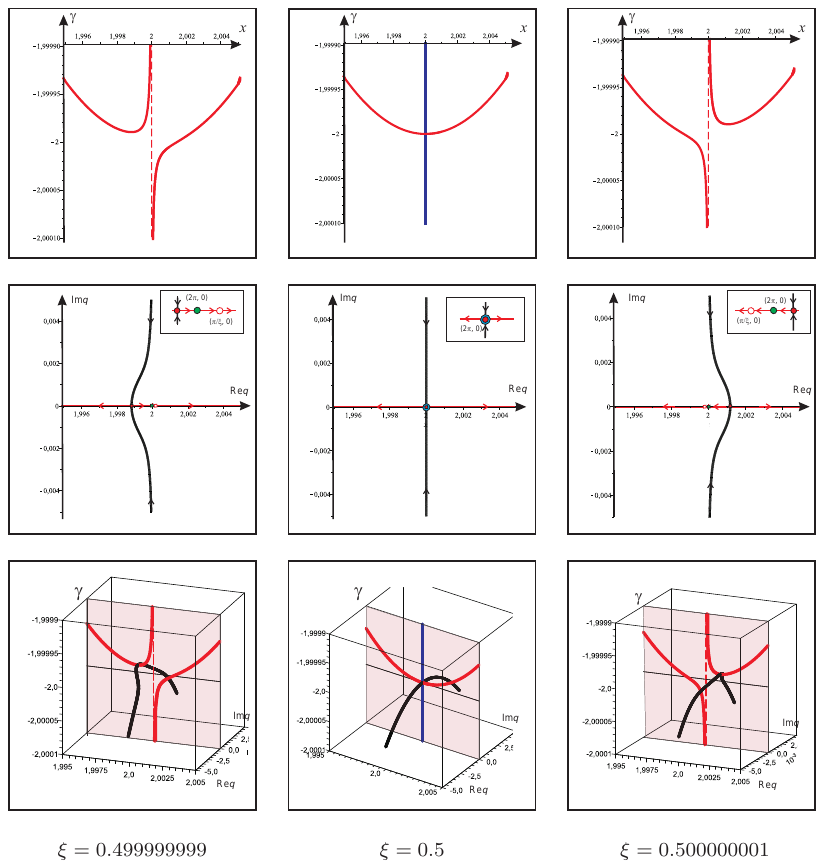
Figure 15. Complex-real characteristic functions (real, domain dependence on the parameter ξ in the neighborhood of the constant eigenvalue point ξ = 0 . 5 and q = 2 π